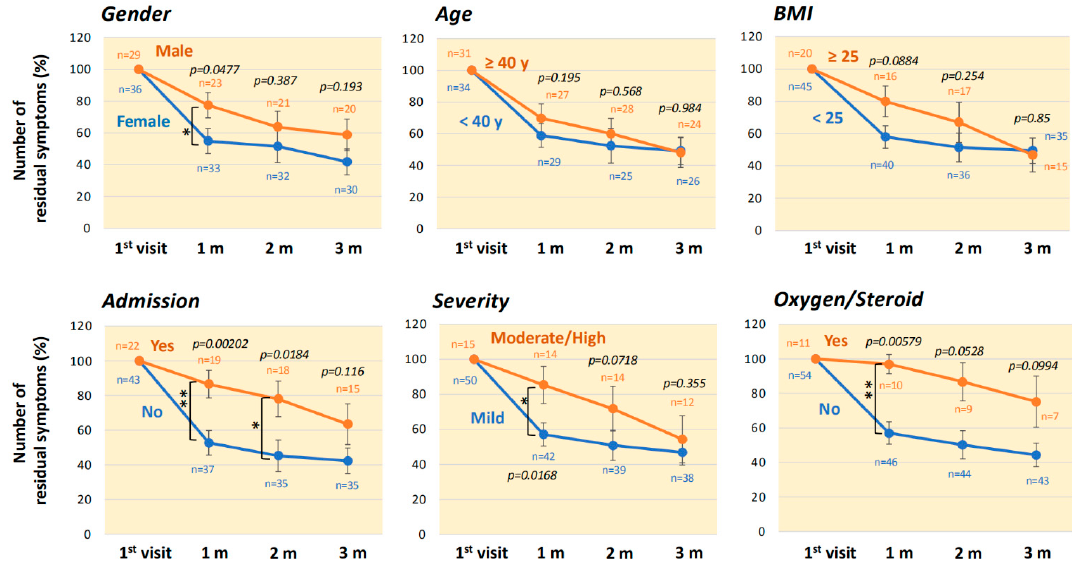
Figure 4. Serial changes in the numbers of residual symptoms in the three-month period according to clinical backgrounds. Changes in the numbers of residual symptoms of long COVID during the three-month period according to patients’ backgrounds and clinical factors related to COVID-19. The data are shown as means ± SEM and were analyzed by the Mann-Whitney U test: ** p < 0.01 and * p < 0.05, statistically significant between the indicated factors (“ n ” indicates the number of patients).